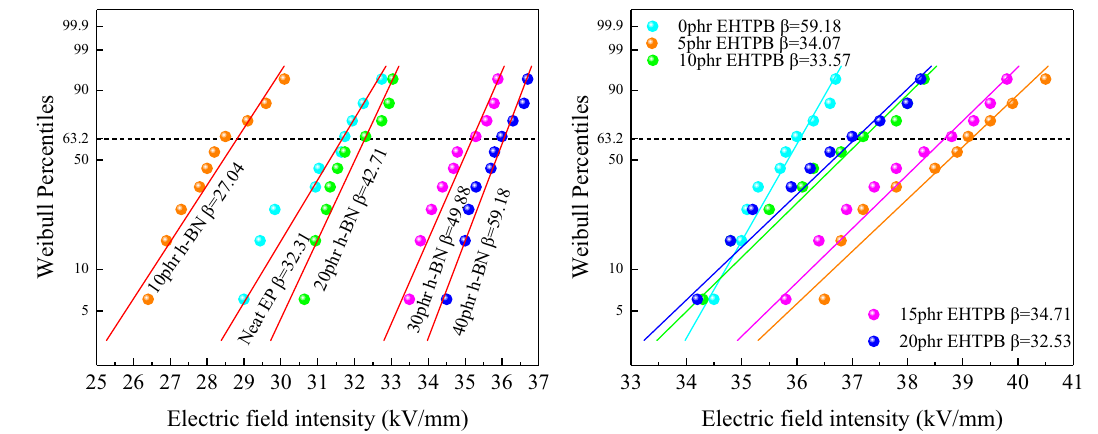
Figure 13: Weibull distribution of breakdown strength values of